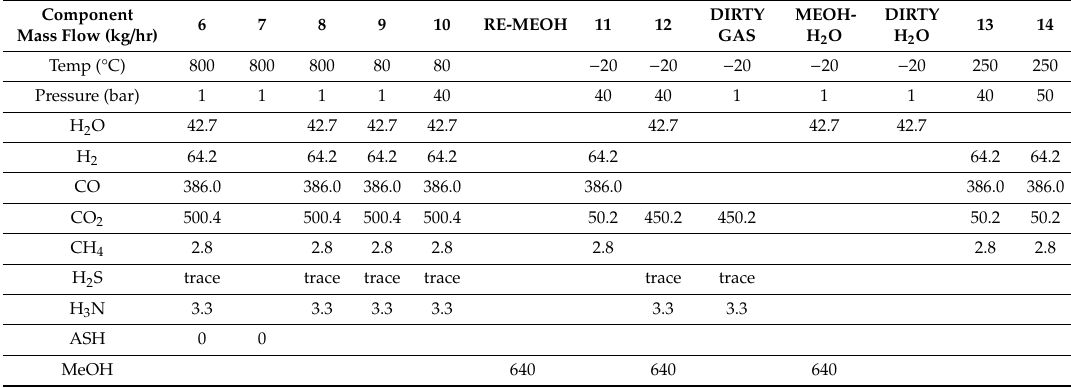
Table A3. Post-treatment flowsheet in Aspen